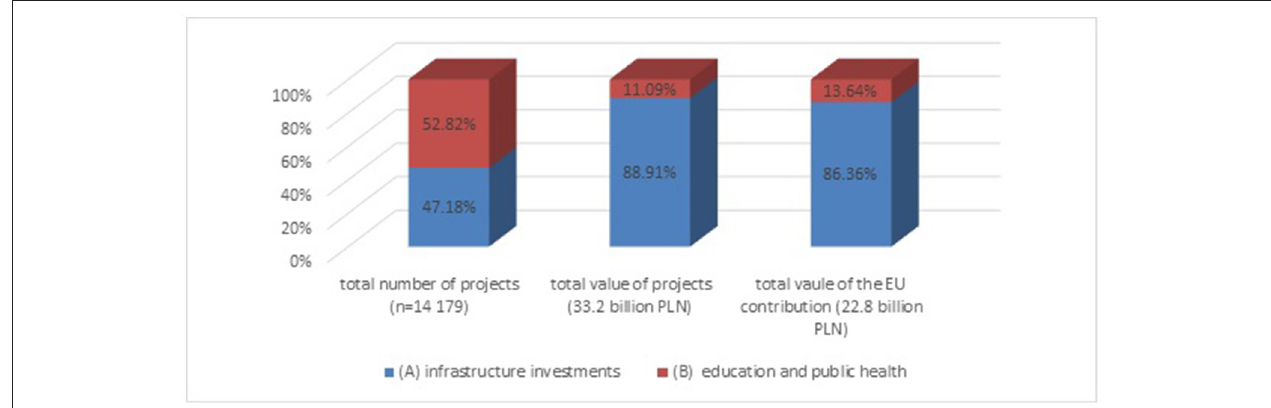
FIGURE 1 | Share of the two types of projects in: the total number of health related projects, their total value, and EU-contribution for health related projects between 2004 and 2020